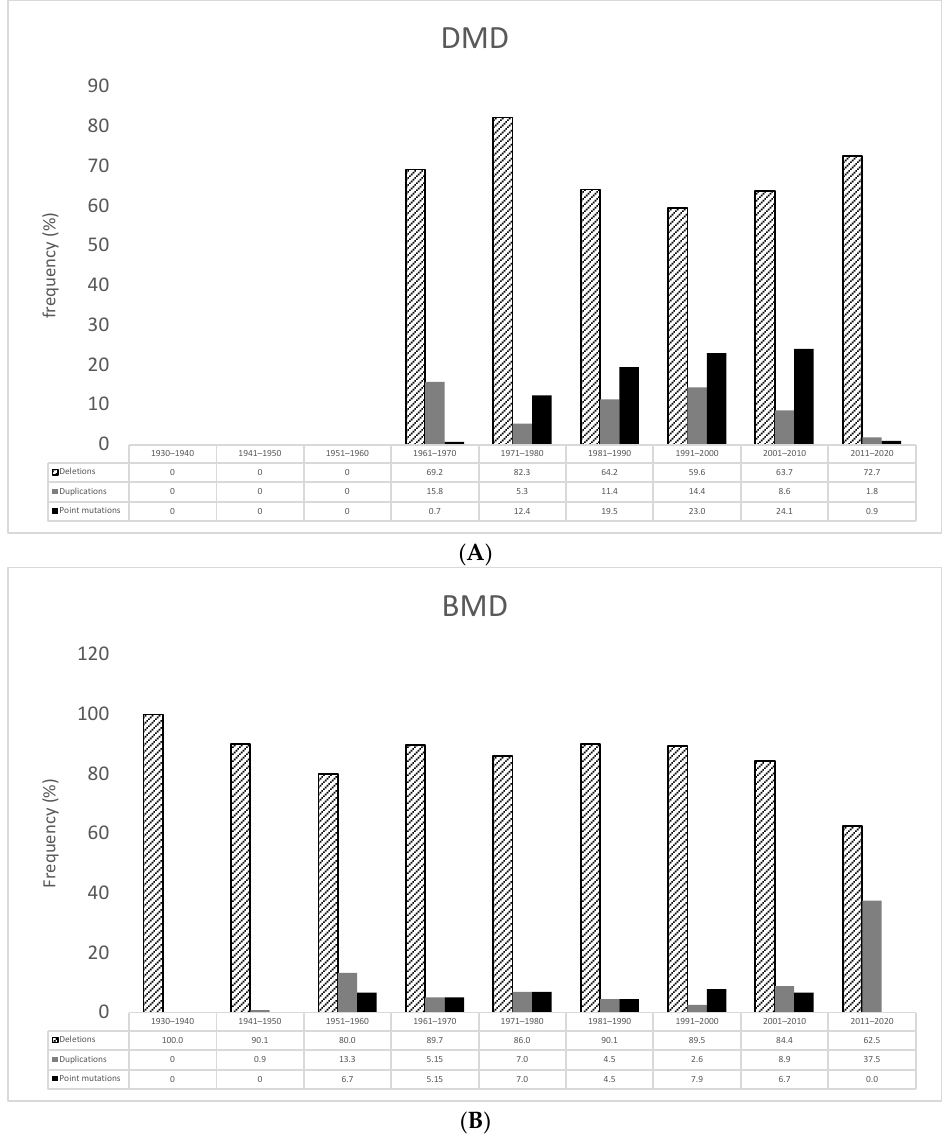
Figure 2. Frequency of mutations in DMD ( A ) or BMD ( B ) analyzed patients according to their decade of birth. The most frequent hot spot of deletions was between E45–E55 (Figure 3A), while the most frequent hot spots of duplications involved exons E2–E23, and less frequently, exons E41–E60 (Figure 3B).